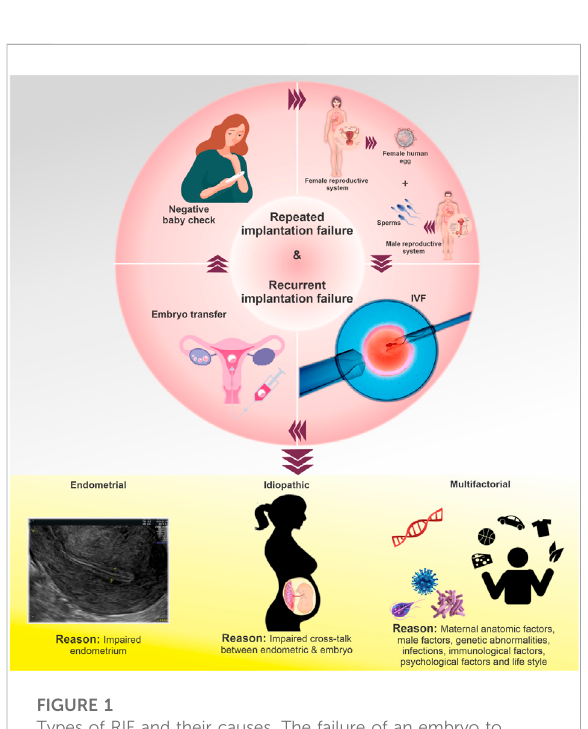
FIGURE 1 Types of RIF and their causes. The failure of an embryo to implant into the uterine wall after multiple transfers during IVF treatment isreferredto as RIF or recurrent implantation failure. RIF types are divided into three categories: Endometrial RIF, which occurs due to the low thickness ( ≤ 6 mm) of the endometrium; idiopathic RIF, which is unexplained failure to achieve pregnancy after the transfer of good quality embryos; multifactorial RIF, which is caused by a wide variety of reasons (male-related factors, genetic abnormalities, infections, immunological factors, psychological factors, lifestyle, and other similar